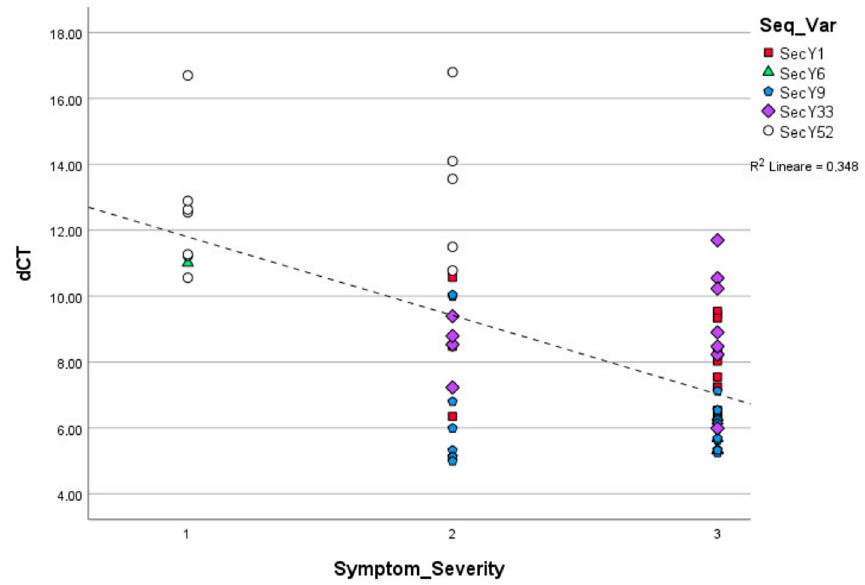
Figure 3. Linear regression among ‘Ca. P. solani’ strains carrying distinct secY sequence variants symptom severity classes observed in grapevines and relative phytoplasma concentration ( p =